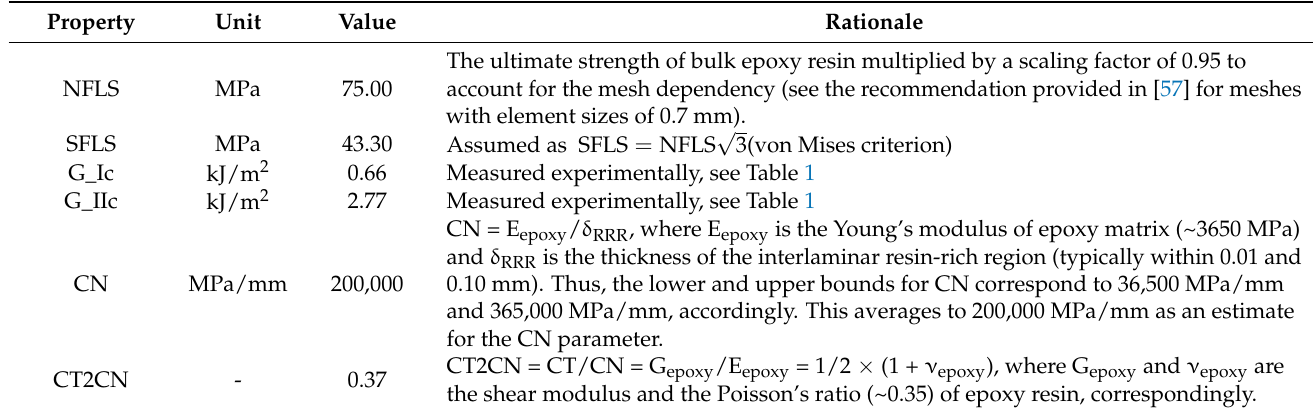
Table 5. Input data for